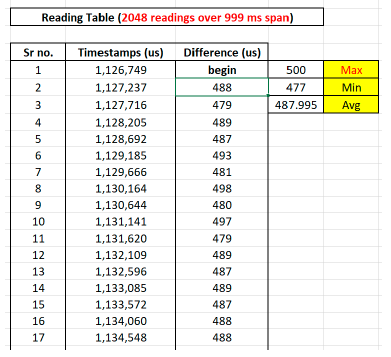
Figure 7. Interrupt generation.